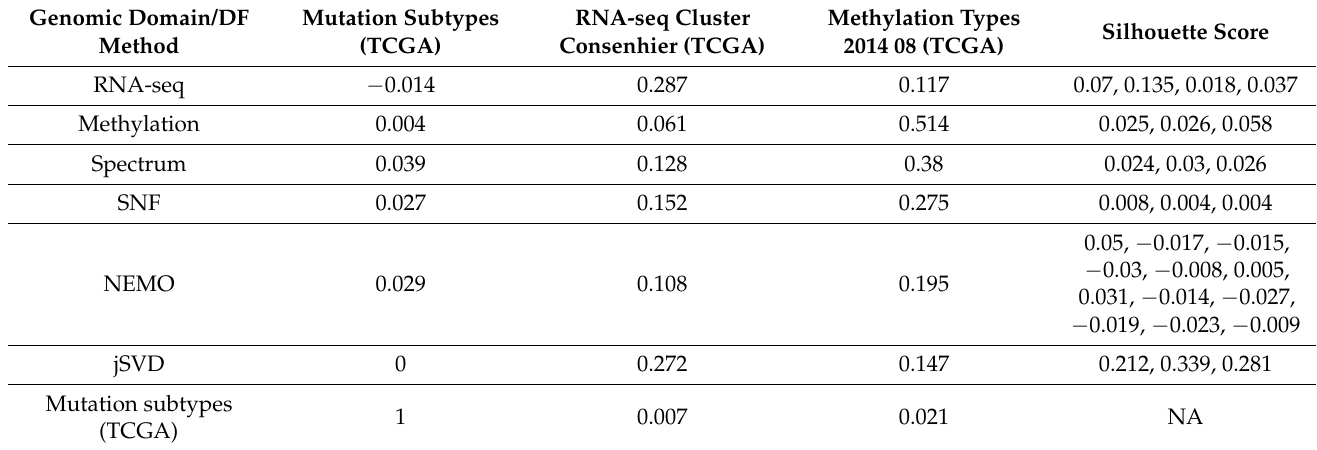
Table 1. Assessment of the DF methods based on the SKCM dataset. The first three columns are the ARI scores as computed by comparing DF clusters and single-domain clusters reported in Supplementary Table S1D of the TCGA paper on the SKCM dataset [14]. The fourth column reports the average silhouette score for each cluster. The first two rows report all indices computed via spectrum clustering on only RNA-seq or methylation matrices. Values of ARI close to 1 represent total agreement between two classification